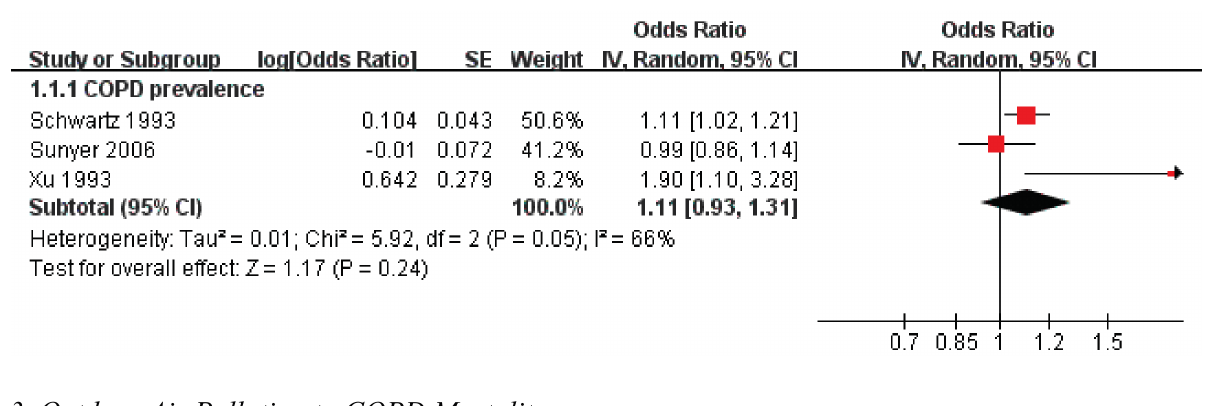
Figure 1. The effect of outdoor air pollution on COPD